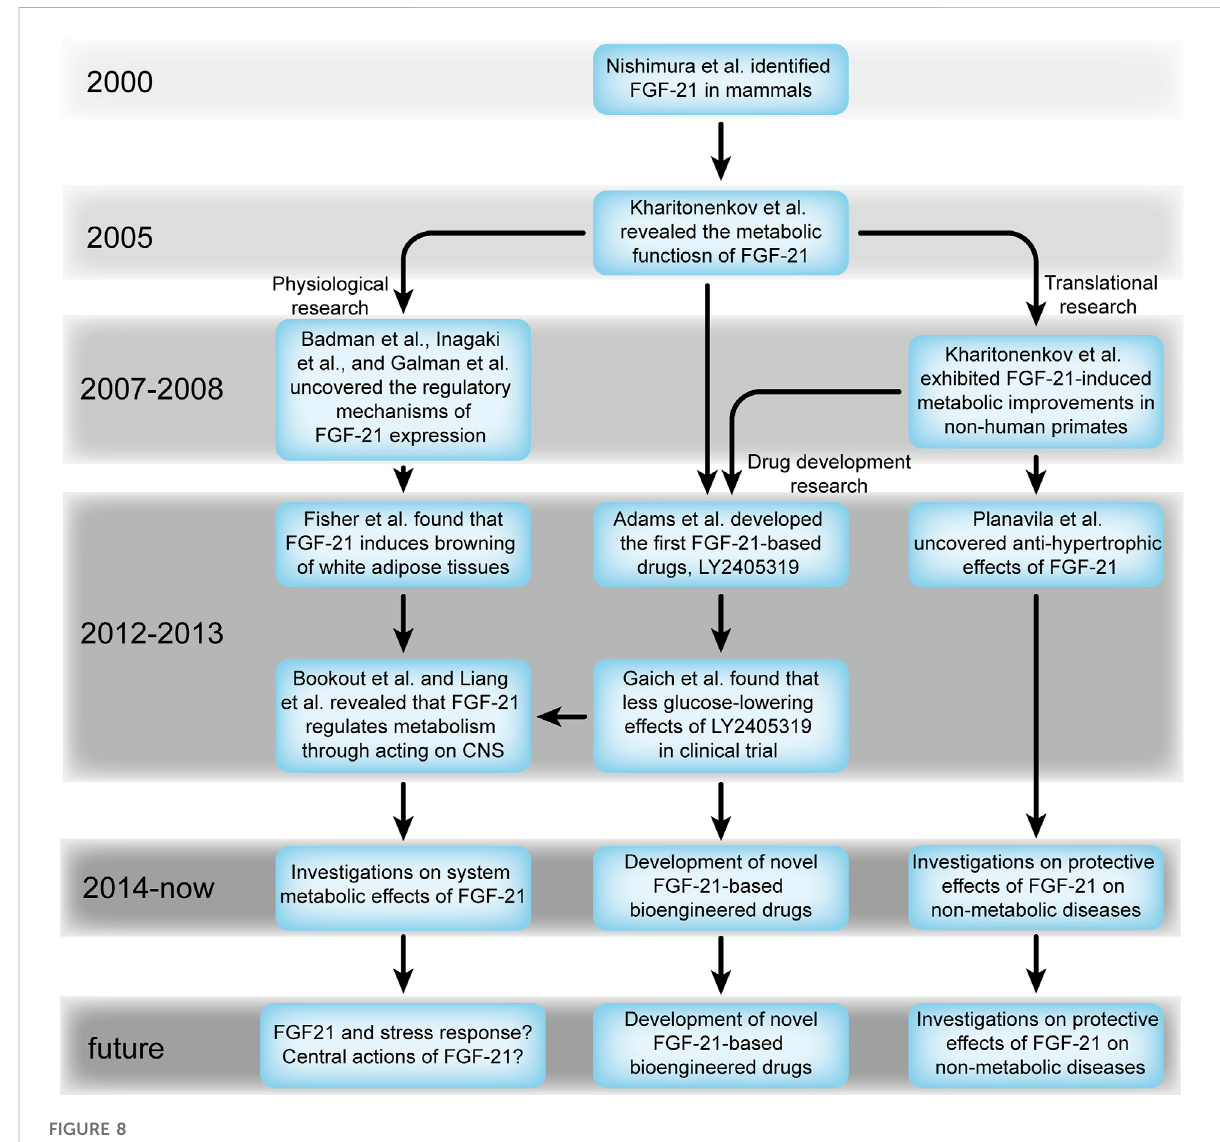
FIGURE 8 Evolving trends of FGF-21 from 2000